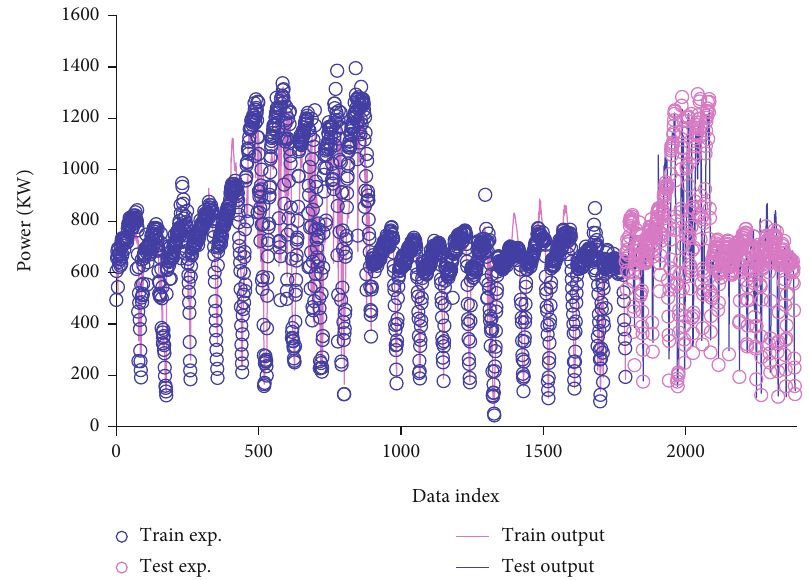
Figure 3: Simultaneous observation of predicted and actual values of the target parameter.